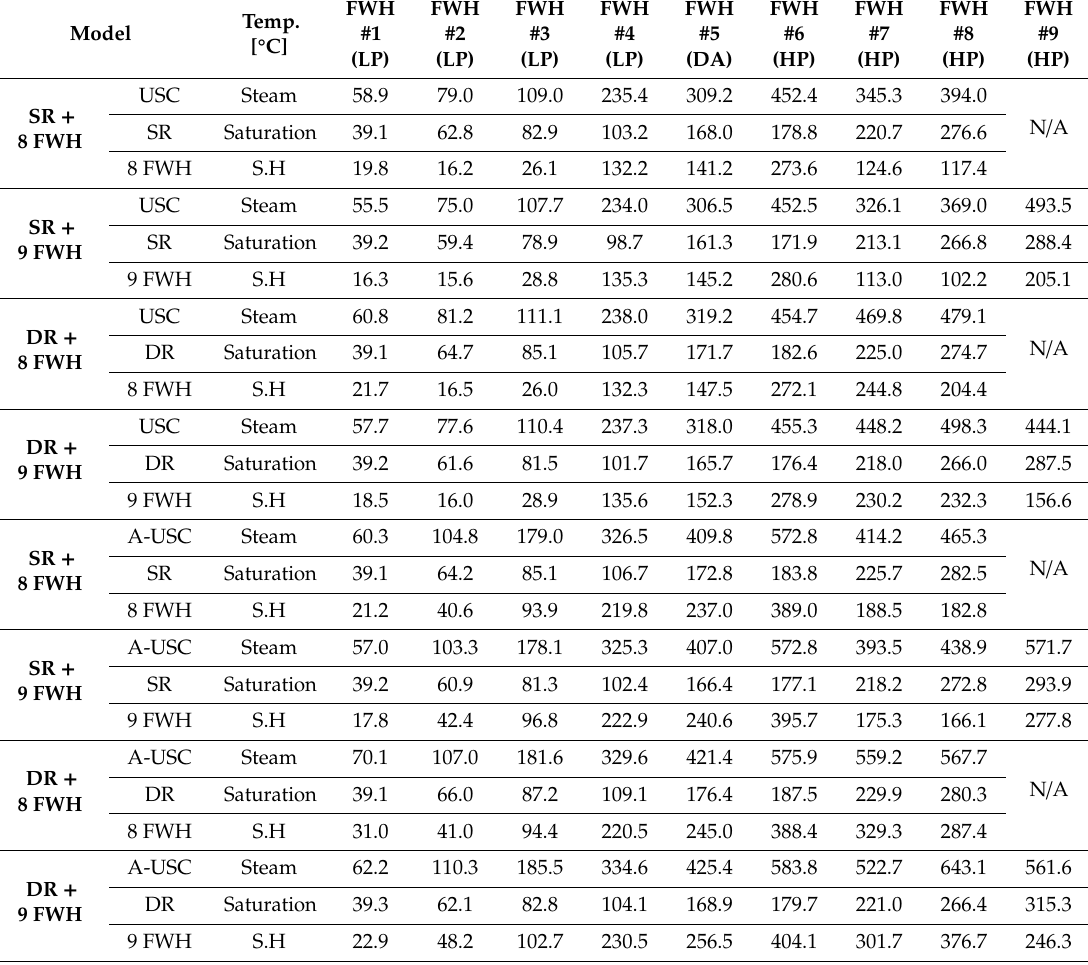
Table 7. Comparison of superheating amongst all models.